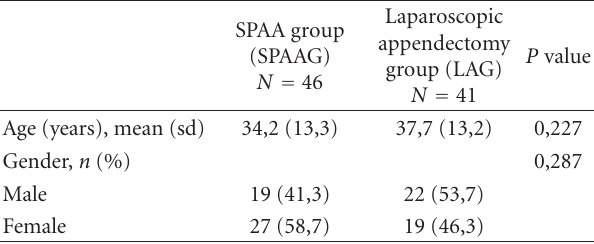
Table 1: Demographic data of the Single Port Access Appendec- tomy Group (SPAA Group) and the Laparoscopic Appendectomy Group (LA